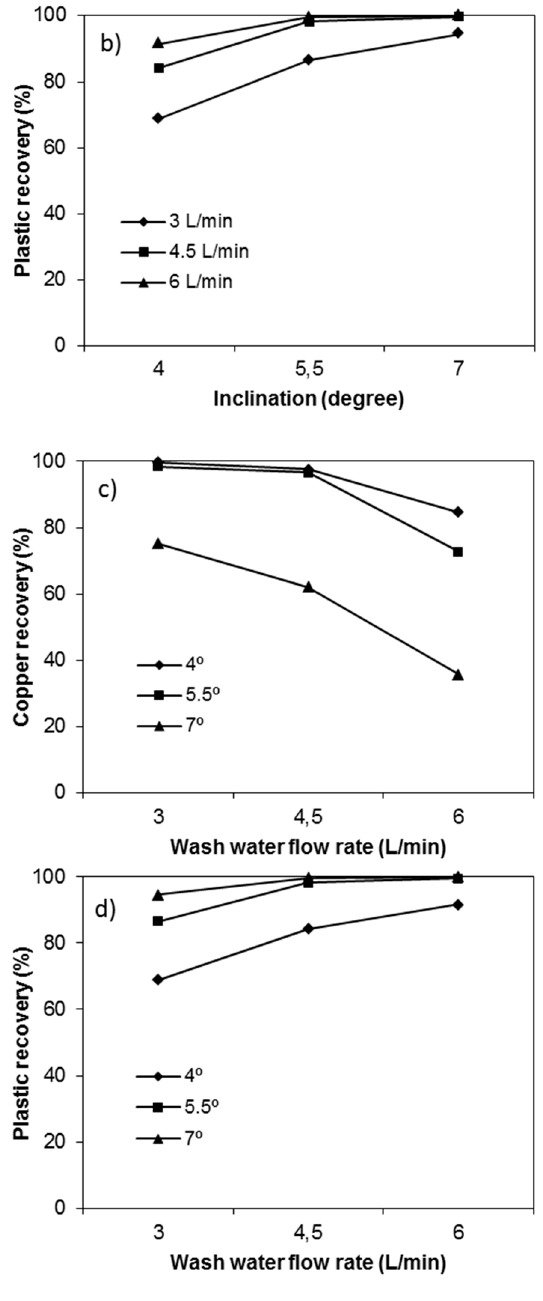
Figure 1. Effect of interaction between table inclination and wash water flow rate on copper recovery ( a , c ) and on plastic recovery ( b , d ).